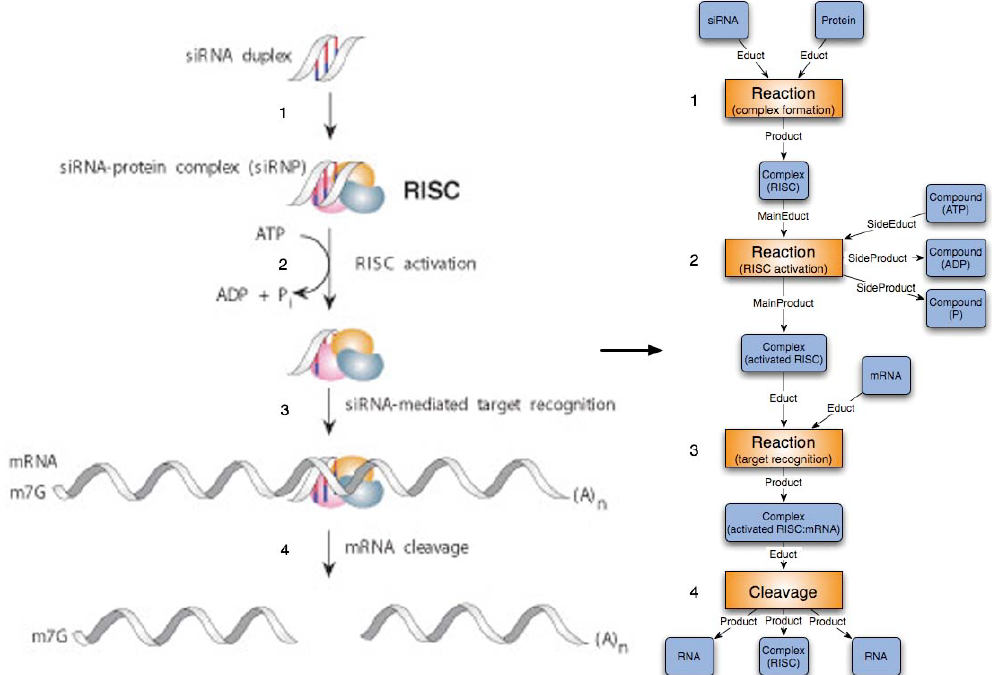
Figure 4: Examplary modeling of gene silencing through RNA interference. The left-hand side shows the biological mechanism starting with the activation of RISC (RNA-induced silencing com- plex) by associaion with siRNA, unwinding of the duplex and removal of one of the strands (with kind permission from Cell Signaling Technology, www.cellsignal.com). The right-hand side of the fi gure illustrates a detailed modeling of this process with BioCore. Blue boxes stand for partici- pants, orange boxes for events, and the edges (arrows) are labeled with the roles the participants play in the particular reaction. Participants and events are labeled with their names (shown in